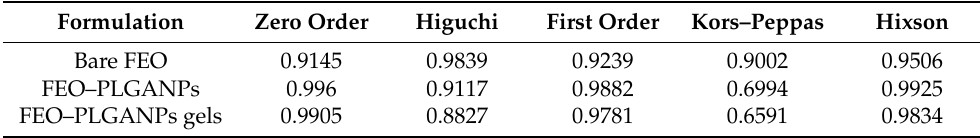
Table 1. Drug-release kinetics of different